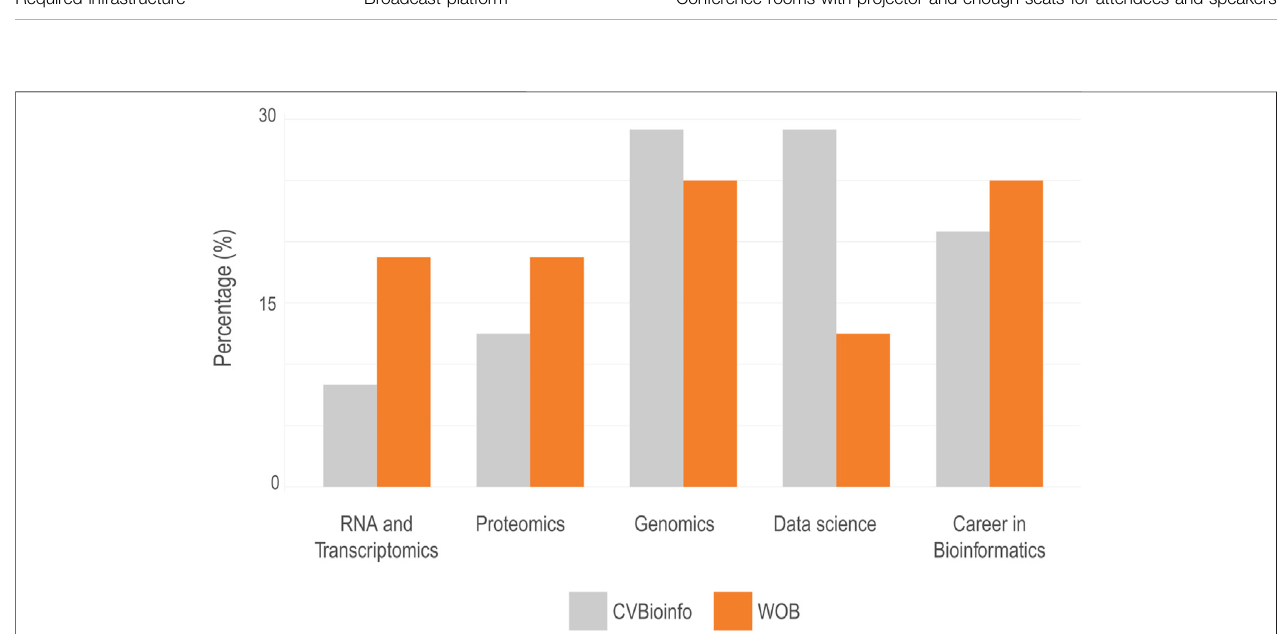
FIGURE1| Proportionofscienti fi cthemesinbioinformaticsfromthescheduleoflecturesofCVBioinfoandWOBevents.Themainthemesofthelectureswere: (A) RNA and transcriptomics; (B) proteomics; (C) genomics; (D) data science; and (E) career in bioinformatics. Total attendees: WOB (cid:1) 2,727; CVBioinfo (cid:1)